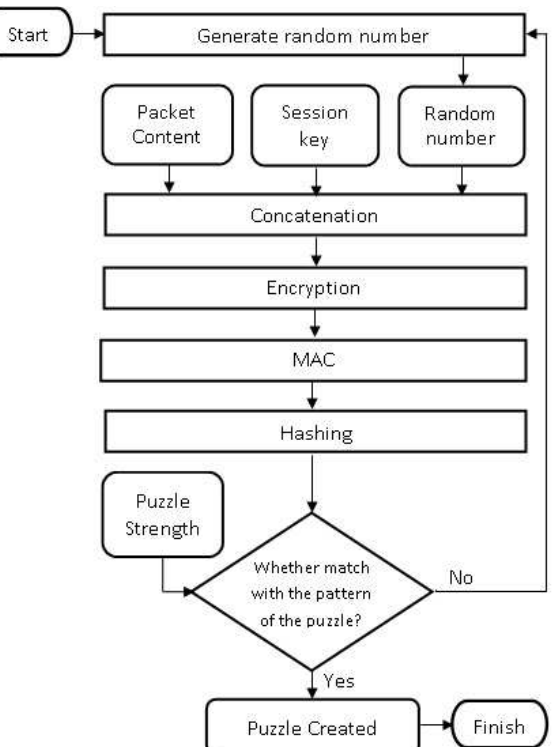
Figure 1. Cipher Puzzle